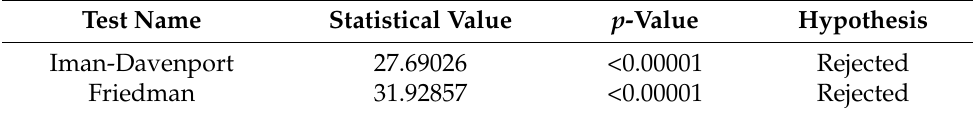
Table 6. Statistical results based on mean of objective Values for shape